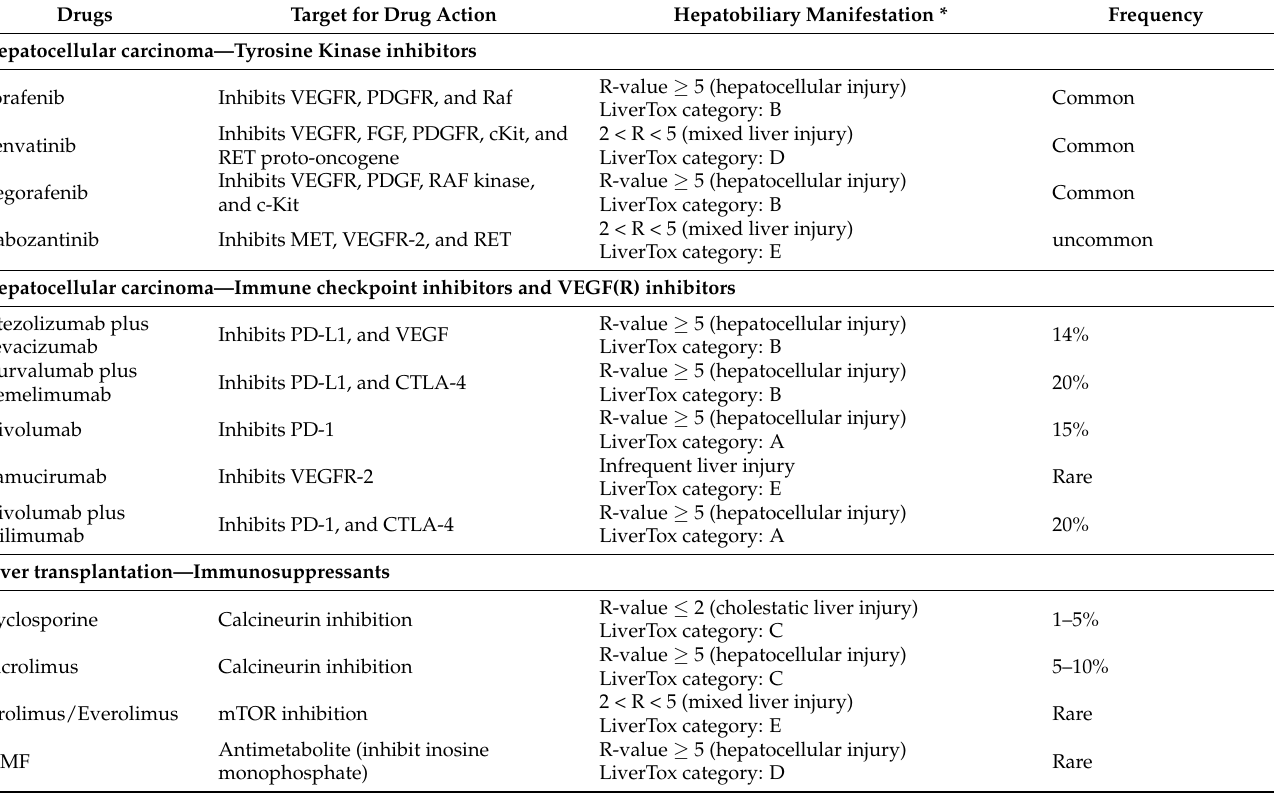
Table 1. Hepatobiliary manifestation and frequency of drug-induced liver injury caused by drugs for treating hepatocellular carcinoma and liver